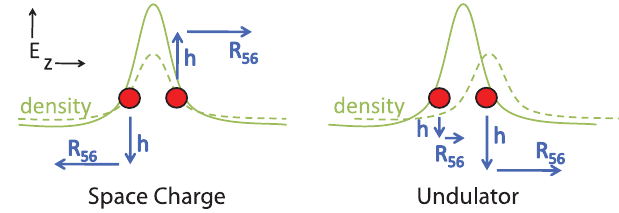
FIG. 2. Schematic of an interaction near a density spike (solid green line). At left, for the space charge case, particles in the front half of the spike gain energy, while particles in the back half lose energy, and in positive dispersion, the density spike shrinks (dotted green line). We have a similar result for an interaction due to undulator radiation (right). At high frequency (spike much shorter than undulator resonant wavelength), all particles lose energy, but following a dispersive region with we still find a reduction in the density spike (dotted negative R 56 green